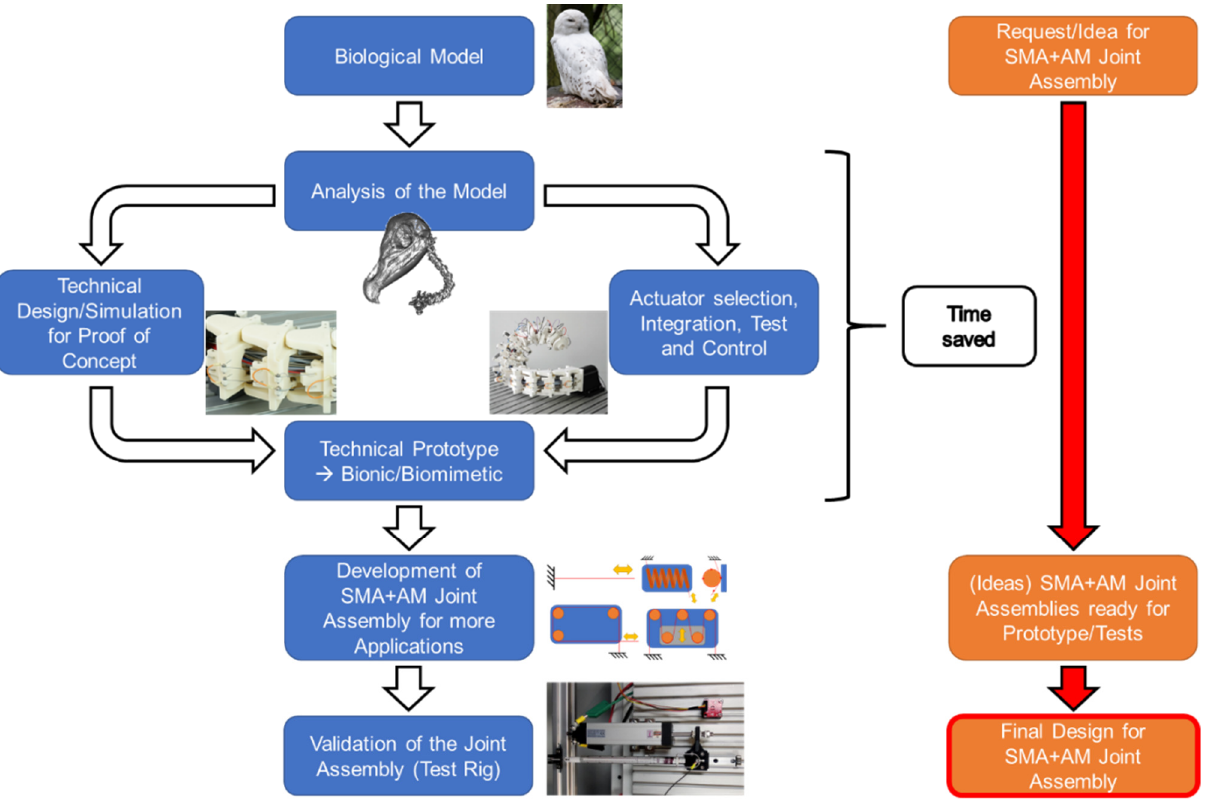
Figure 2. Flowchart illustrating the research process (left/blue) compared to the streamlined devel- opment process using the research results (right/orange).